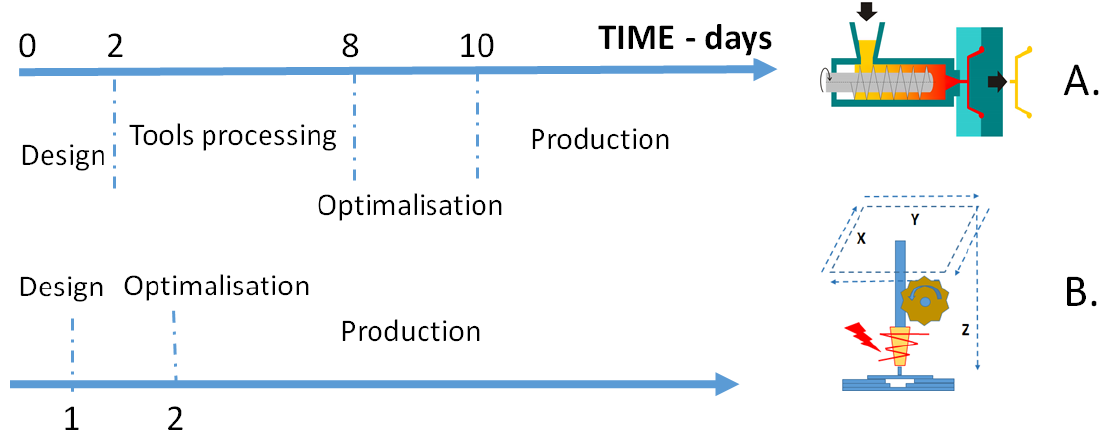
Figure 1. Comparison of the time needed to start the production process for injection molding technology ( A ) and rapid prototyping—3D printing, e.g., FFF ( B ).